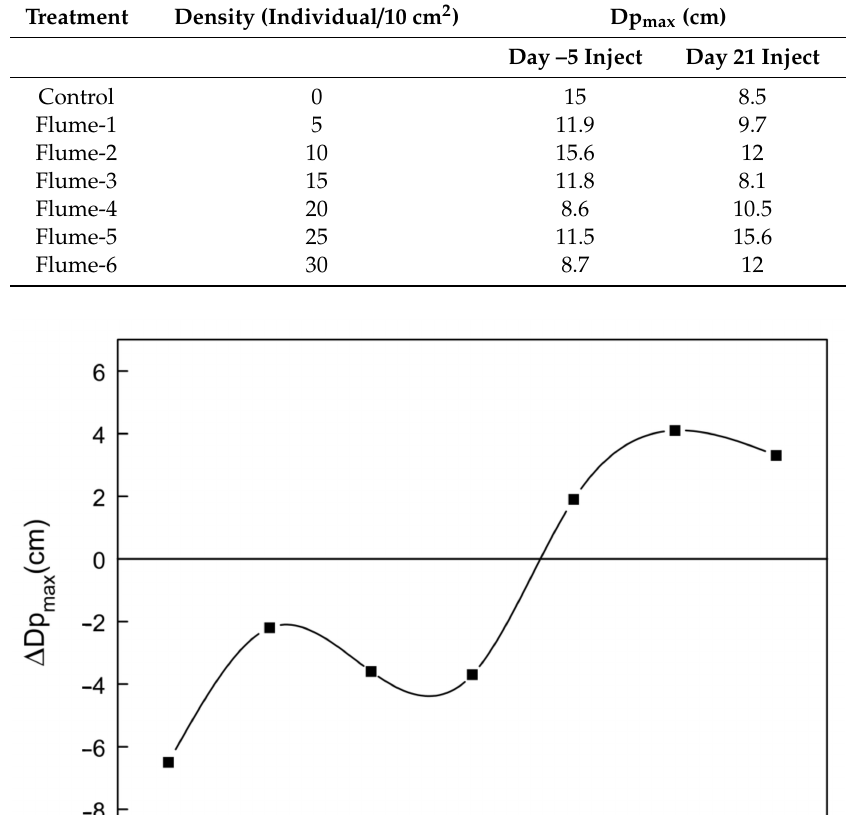
Table 1. The penetration depth measured before and after 21-day bioturbation period under seven biological densities.